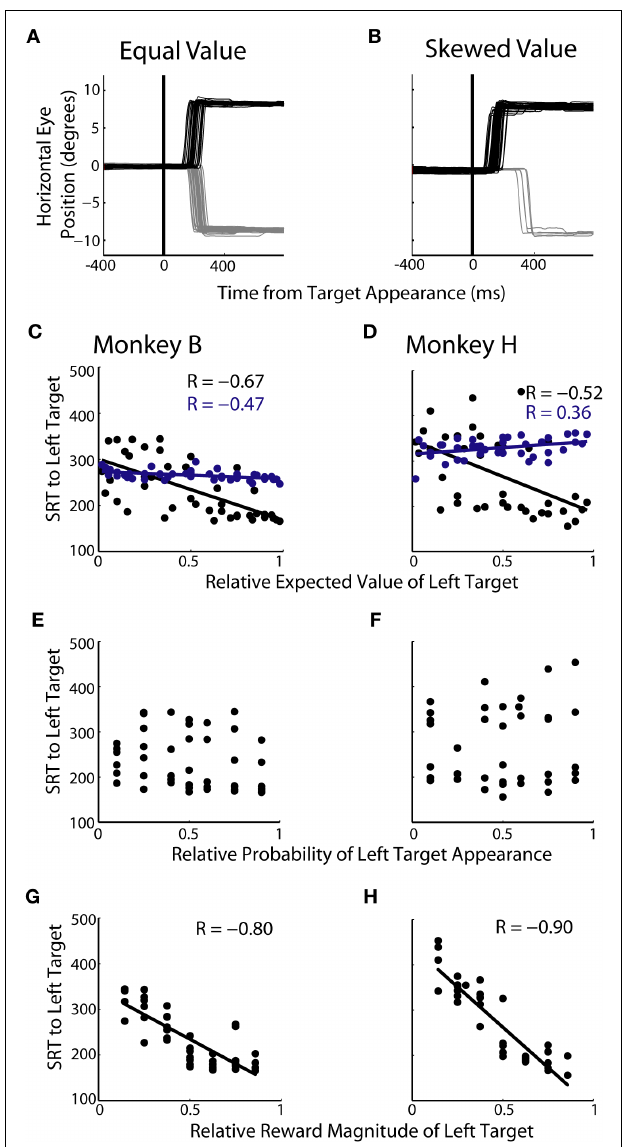
FIGURE 4 | Influence of decision factors on SRT during single-target trials. (A,B) Individual eye traces for equal value (50% left probability/50% left reward magnitude) and skewed value (10% left probability/38% left reward) blocks of trials. (C,D) Relationship between relative expected value of the left target and SRT for each monkey. Each black point represents 150–225 single-target trials of a specific prospect collapsed across two to three blocks of trials. Each blue point represents 50–75 two-target trials collapsed across two to three blocks of trials. (E,F) Relationship between probability and SRT for each monkey. (G,H) Relationship between reward magnitude and SRT for each monkey.